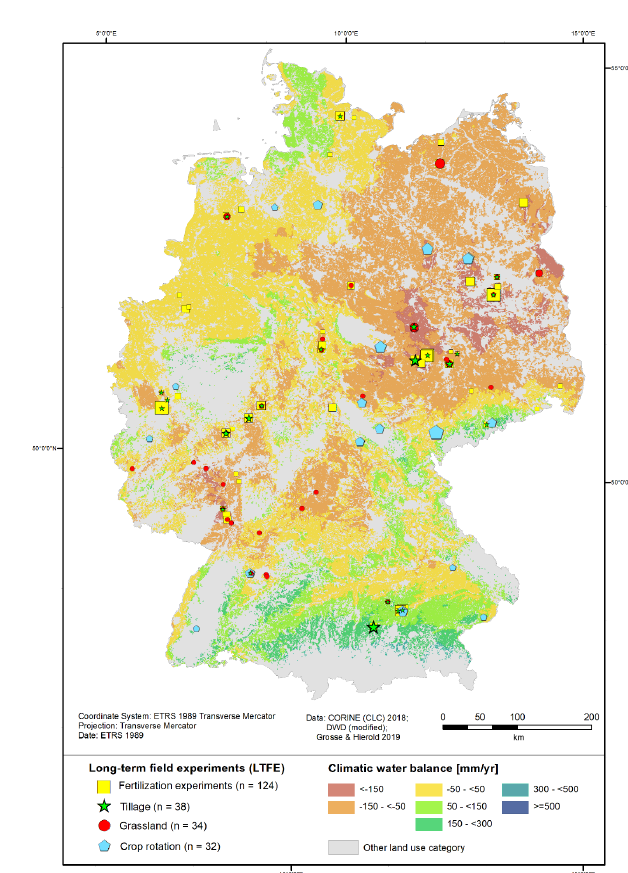
Figure 5. Overview of the distribution of the different Müncheberg Soil Quality Rating classes and the different LTFE types in Ger- many. The size of the symbols varies according to the number of LTFEs at one